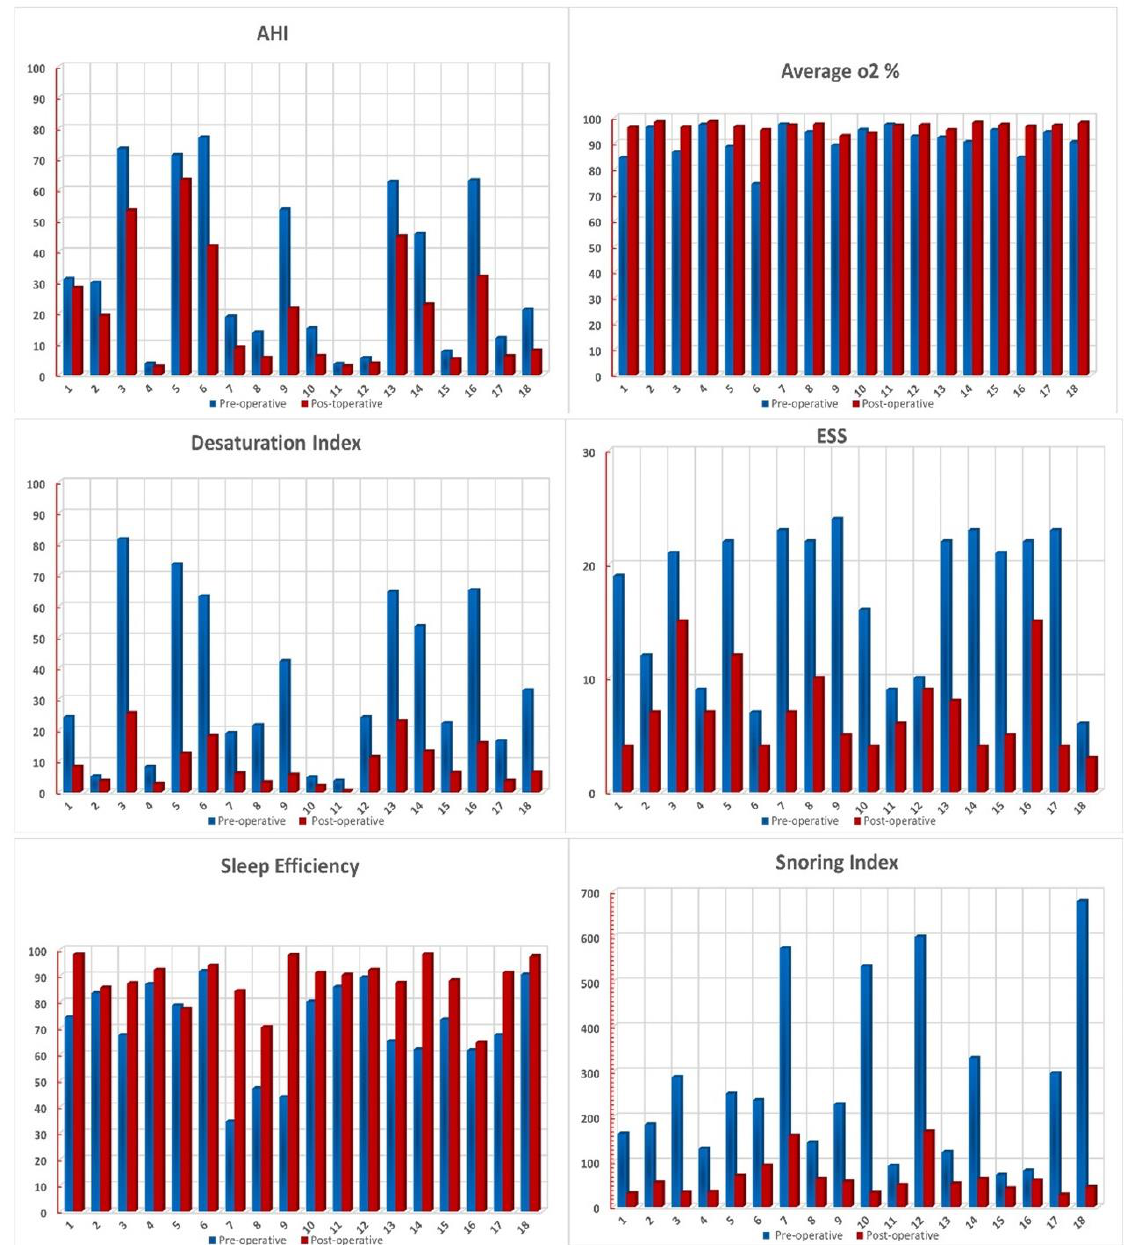
Figure 2. Graphic presentation of the pre- and postoperative values of the studied cases.